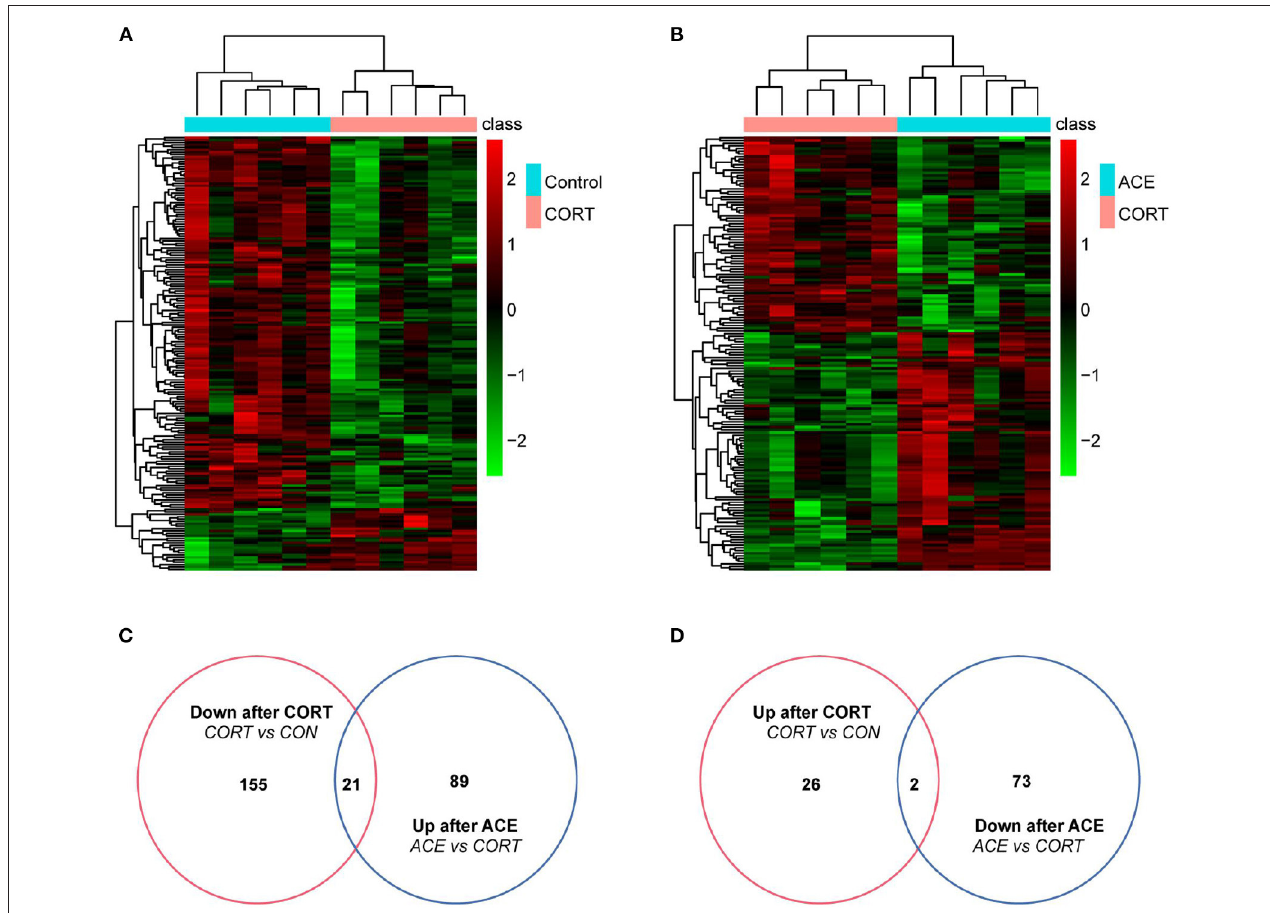
FIGURE 5 | Differential metabolites expression in the brain of mice between the CON, CORT, and ACE groups. (A) Heatmap of differentially expressed metabolites between CON and CORT samples with green and red spectrum colors indicating downregulated and upregulated expression, respectively ( p < 0.05, n = 6 per group). (B) Heatmap of differentially expressed metabolites between ACE and CORT samples with green and red spectrum colors indicating downregulated and upregulated expression, respectively ( p < 0.05, n = 6 per group). (C,D) Venn diagrams showed the overlaps of differentially expressed metabolites between experimental groups. A total of 21 metabolites decreased in CORT group but increased in ACE group. A total of 2 metabolites increased expression in CORT group but decreased in ACE